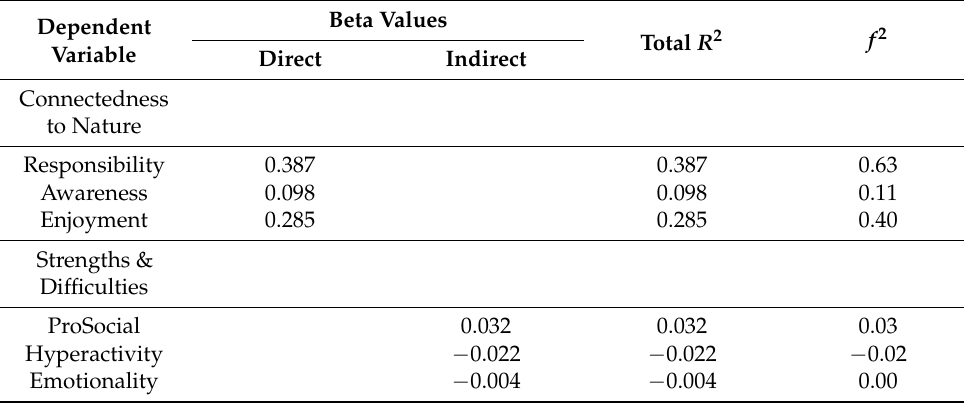
Table 1. Effect sizes of